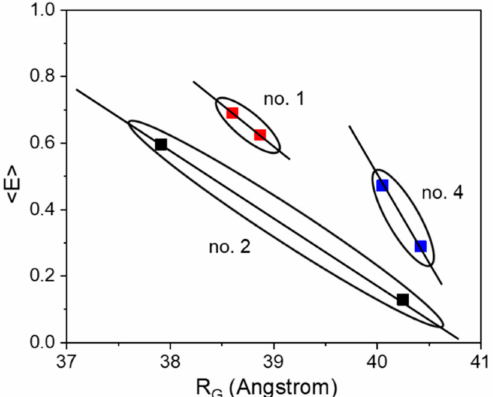
Figure 2. The correlation between energy transfer change and change in R G is shown for the three investigated sensor constructs. Although we do not expect a strict linear relationship between <E> and R G , the solid lines do not represent fits, but should visualize a general